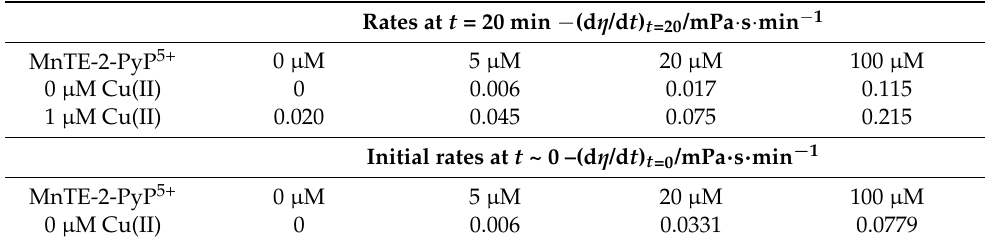
Figure 6. Time-dependent changes in dynamic viscosity ( η ) of the HA solution subjected to MnTE-2-PyP 5+ at concentrations 0 (black curve), 5 (green curve), 20 (blue curve), and 100 µ M (cyan curve) and 100 µ M ascorbate in the absence of Cu(II) ( A ) and in the presence of 1 µ M Cu(II) ( B ), as well as the corresponding first derivative curves in time (d η /d t = f( t )) in the absence of Cu(II) ( C ) and in the presence of 1 µ M Cu(II) ( D ). The HA concentration was 1.75 mg/mL. Table 2. The values of the rates at 20 min of the process of HA degradation, − (d η /d t ) t =20 are listed and are derived from the time-dependent changes in dynamic viscosity ( η ) of the HA solution subjected to MnTE-2-PyP 5+ at different concentrations and 100 µ M ascorbate in the presence or in the absence of 1 µ M Cu(II). Initial rates, − (d η /d t ) t =0 : the rate at t ~0